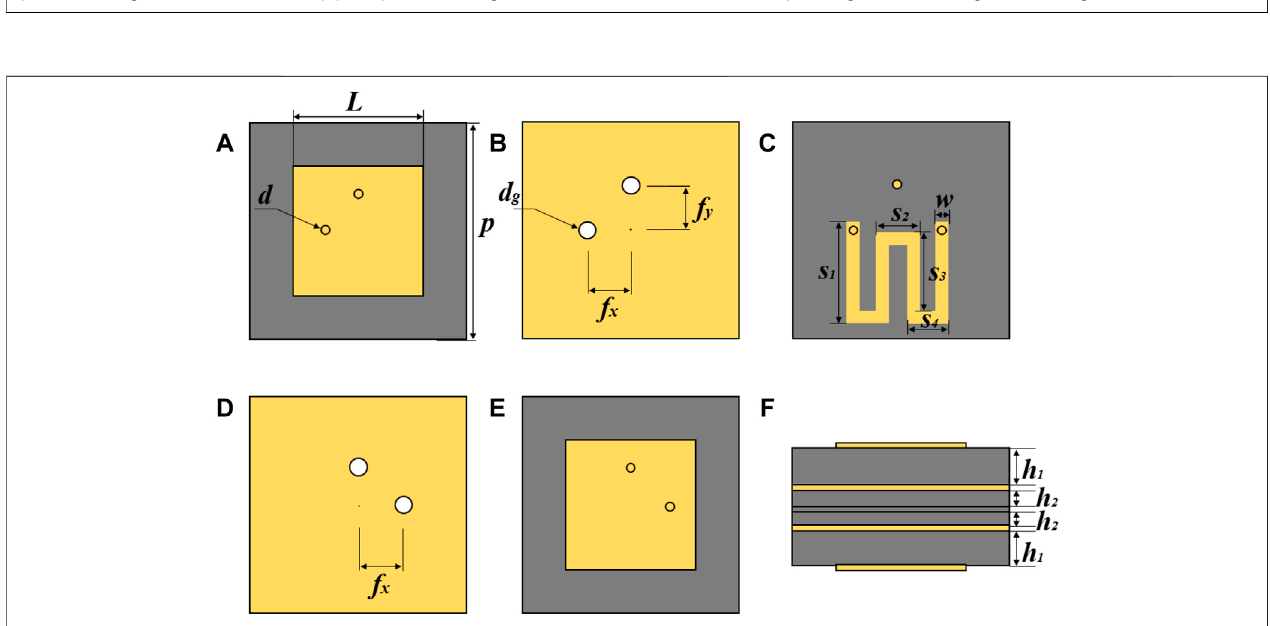
FIGURE 2 | The geometry of the proposed continuous polarization angle rotation DPM unit. (A) The top patch and its feed points. (B) The ground layer; (C) The middle layer of stripline. (D) The ground layer; (E) The bottom patch and its feed points. (F) The side view of the DPMs unit.